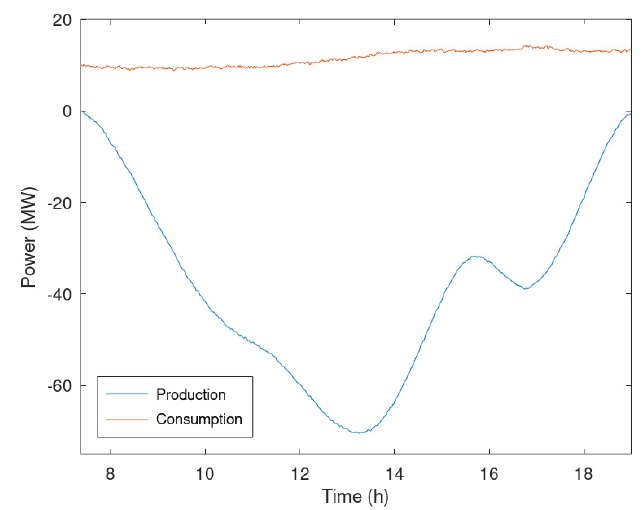
Figure 6. Global power profiles in case of production peak used in the case study.